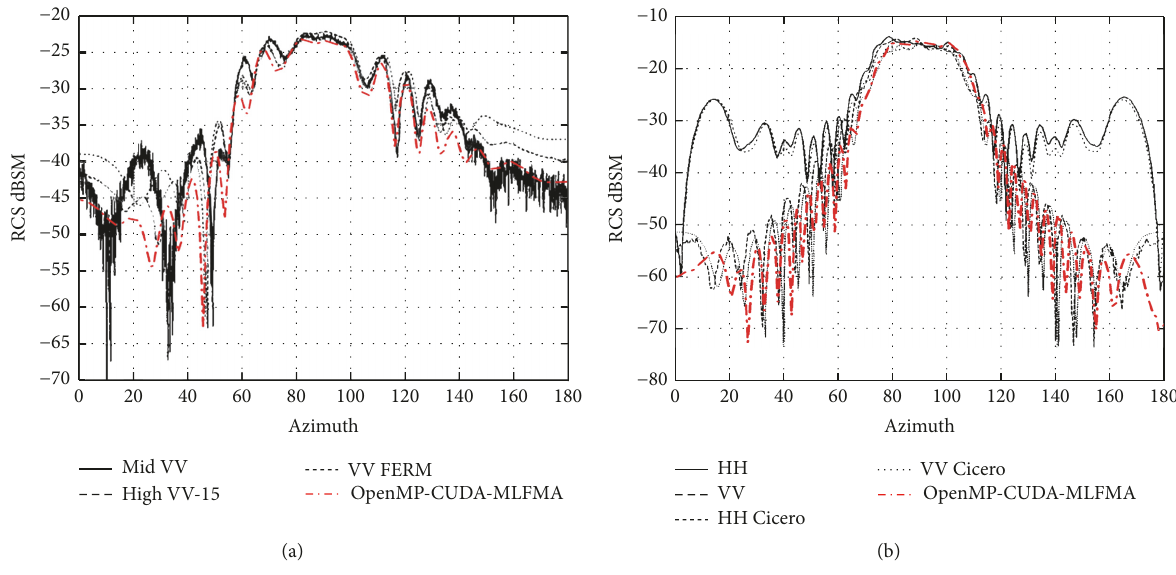
Figure 6: (a) The monostatic RCS at 7GHz for VV polarization. (b) The monostatic RCS at 9 GHz for HH